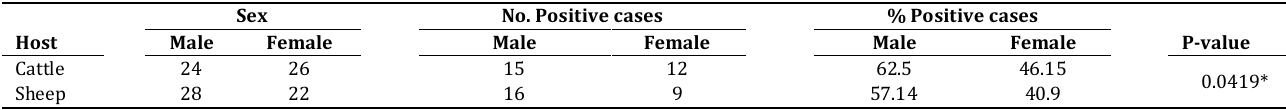
Table 2. Infection rate of Entamoeba spp in cattle and sheep according to sex Sex No. Positive cases